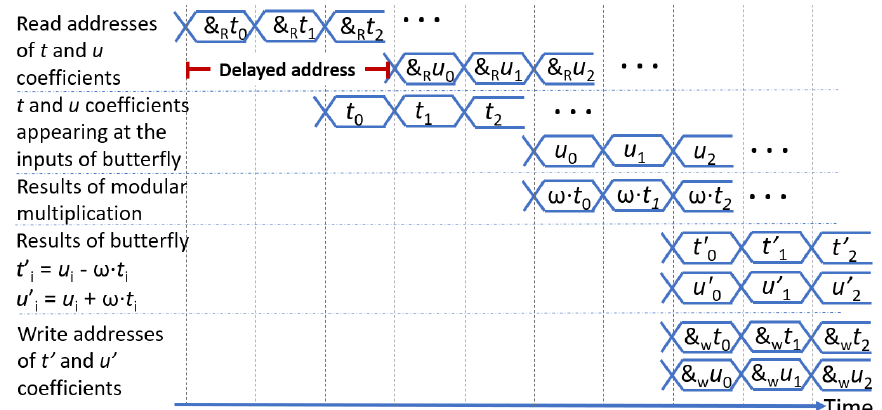
Figure 3: The timing diagram for our DiT method of NTT. Due to pipelined